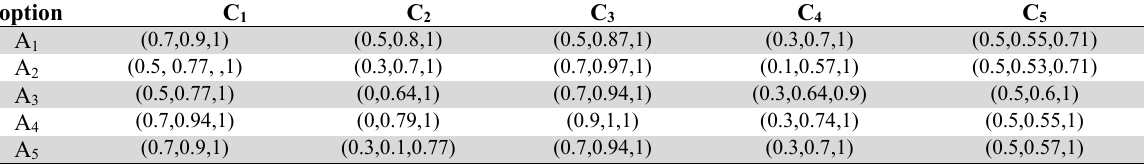
Results of the descaled weighted decision